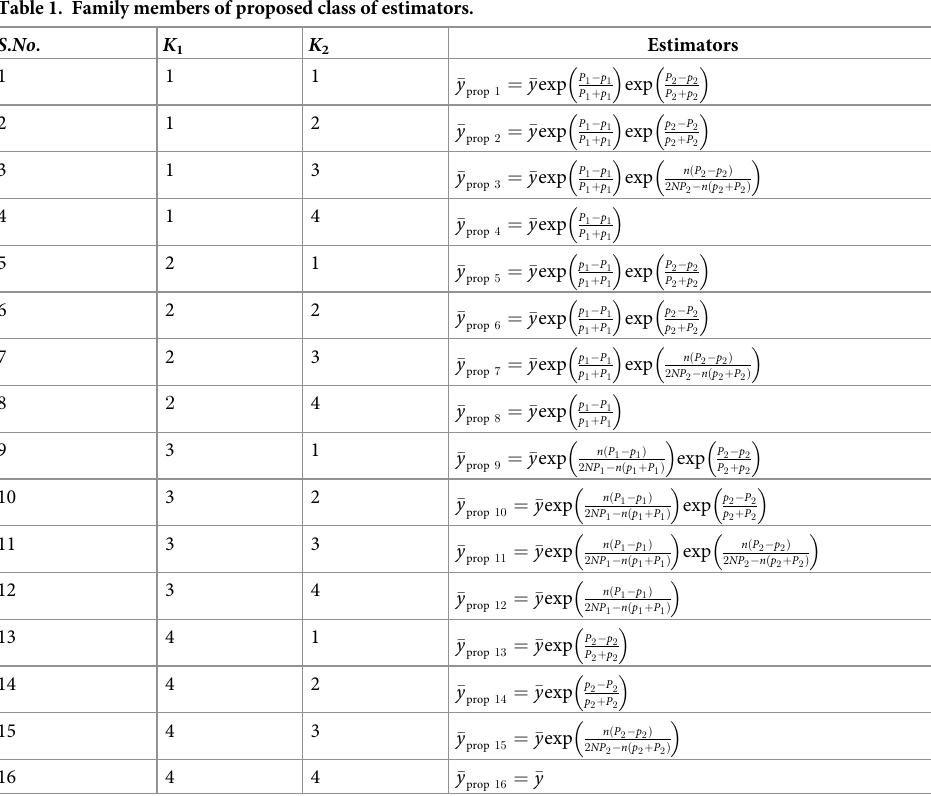
Table 1. Family members of proposed class of